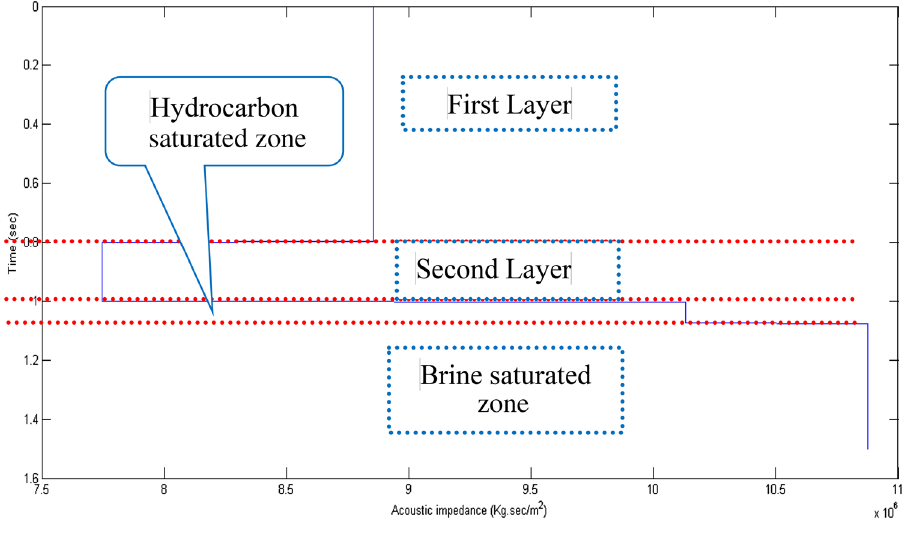
Fig. 6 Fluid density plot of case